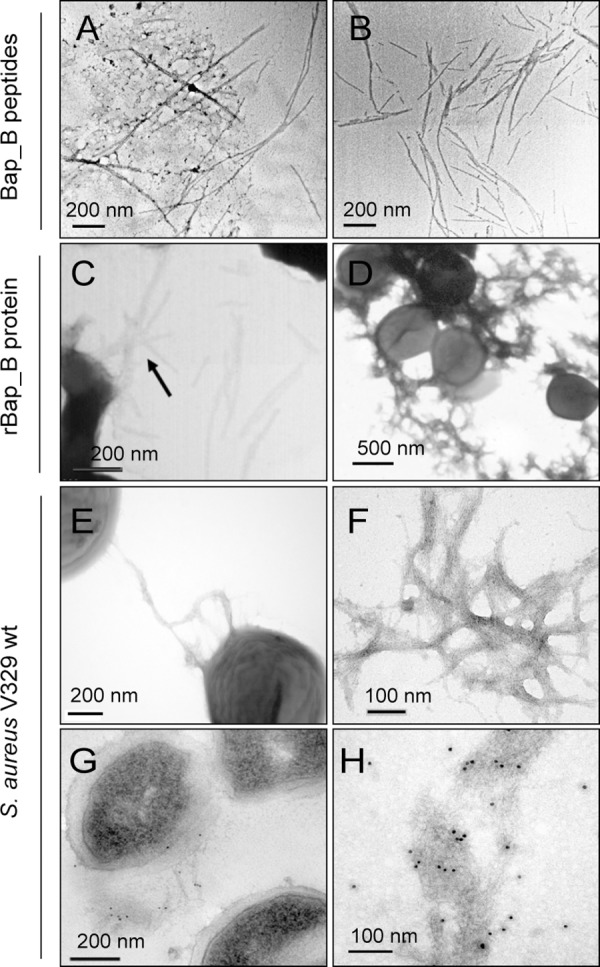
Bap forms amyloid-like fibers.A-B) Electron micrographs of negatively stained fibers formed by amyloid Bap_B peptide I and amyloid Bap_B peptide II respectively. C) Negatively stained fibers formed by purified rBap_B protein. Protein was incubated 24 h in phosphate-citrate buffer pH 4.5. D) Electron micrographs of S. aureus ∆bap cells grown in LB-glu (pH<5) incubated with 2 μM purified rBap_B protein. E) Electron micrographs of negatively stained S. aureus V329 cells grown in LB-glu (pH<5) for 24 h. G) Immunogold labeled samples from S. aureus V329 cells grown in LB-glu (pH<5) for 24 h using anti-Bap B antibodies. Fibers are shown at higher magnification in F and H.